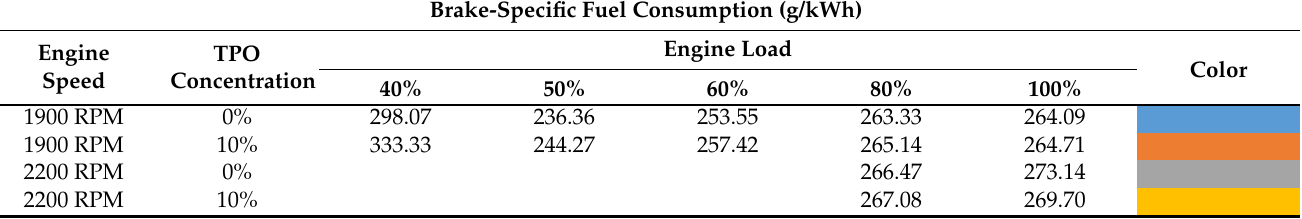
Figure 7. Fuel consumption of the engine. Table 5. Measured fuel consumption values.